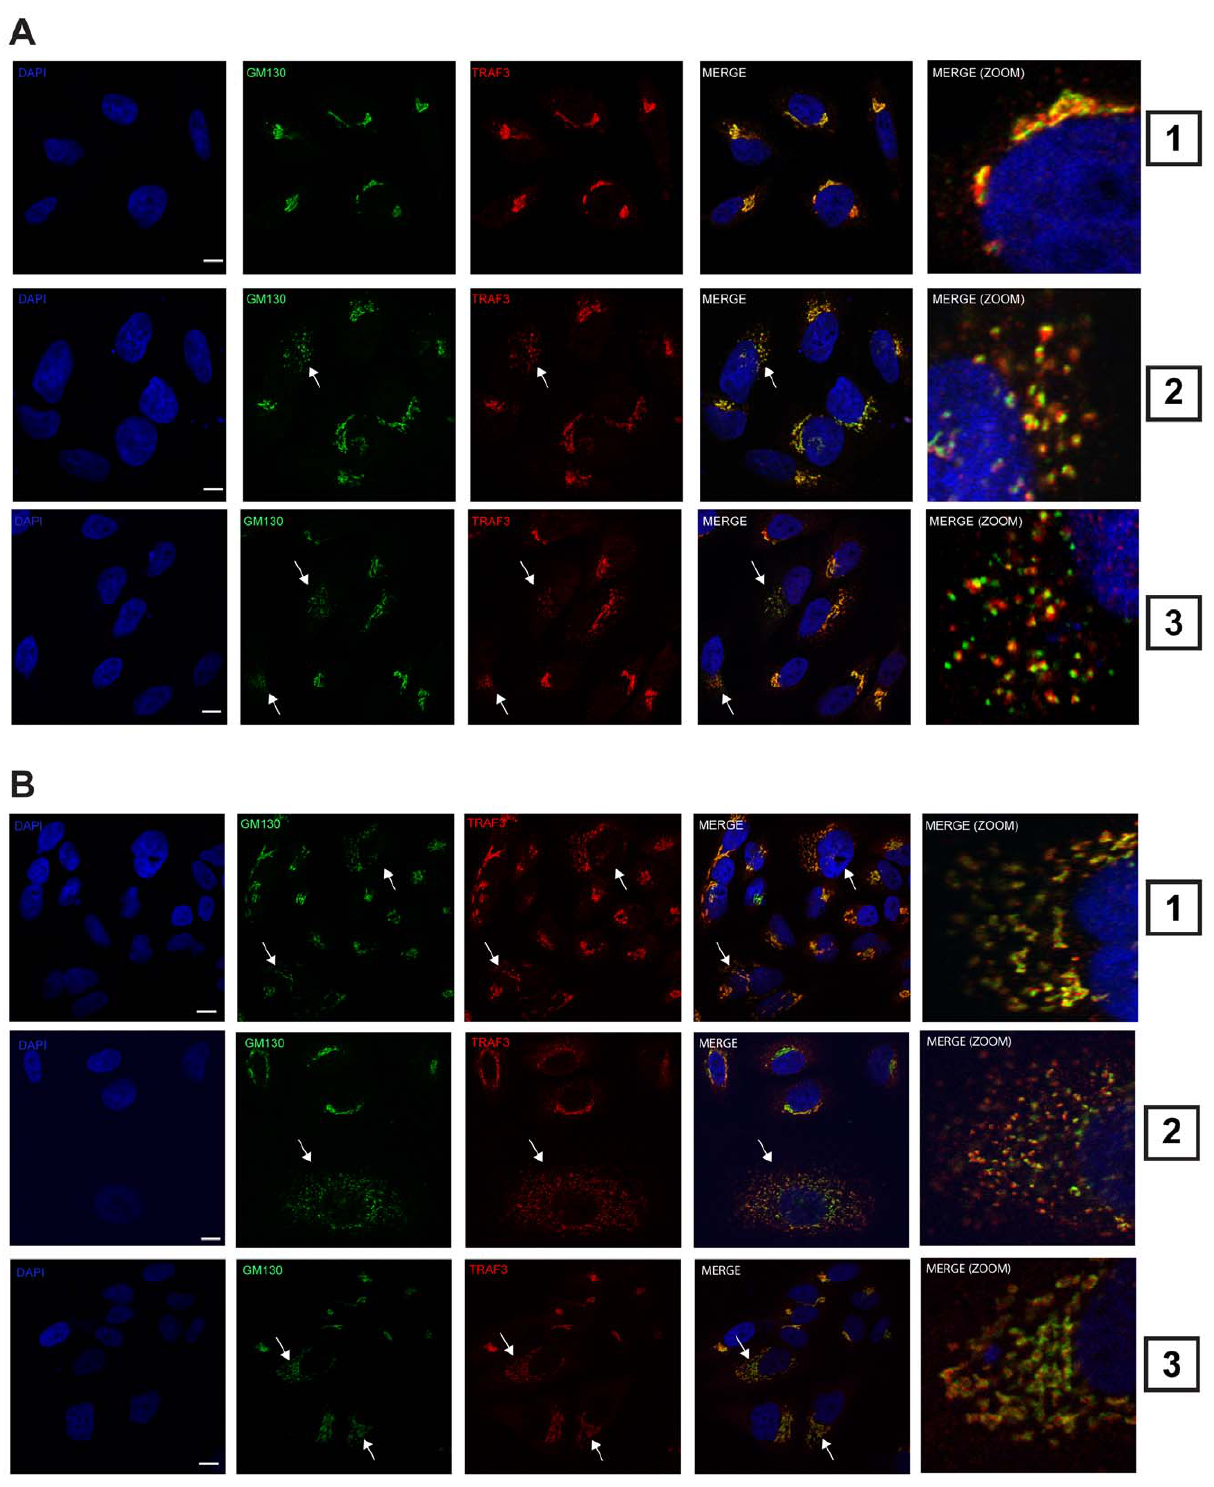
Figure 4. Activation of intracellular RNA and DNA sensors leads to the formation of TRAF3-contraining Golgi fragments. Confocal microscopy of HeLa cells stained for endogenous TRAF3, GM130, and the nucleus (DAPI) upon no treatment ( A , panel 1), poly I:C treatment ( A , panel 2) or poly dA:dT for 4 h ( A , panel 3), infection with SeV (200 HAU/ml) ( B , panel 1), RSV (MOI=3) ( B , panel 2), or Influenza A virus for 4 h ( B , panel 3). Arrows indicate the relocalization and the colocalization of the Golgi apparatus with TRAF3 upon treatment. Bars represent 5 m m. One of three independent experiments with similar results is shown.